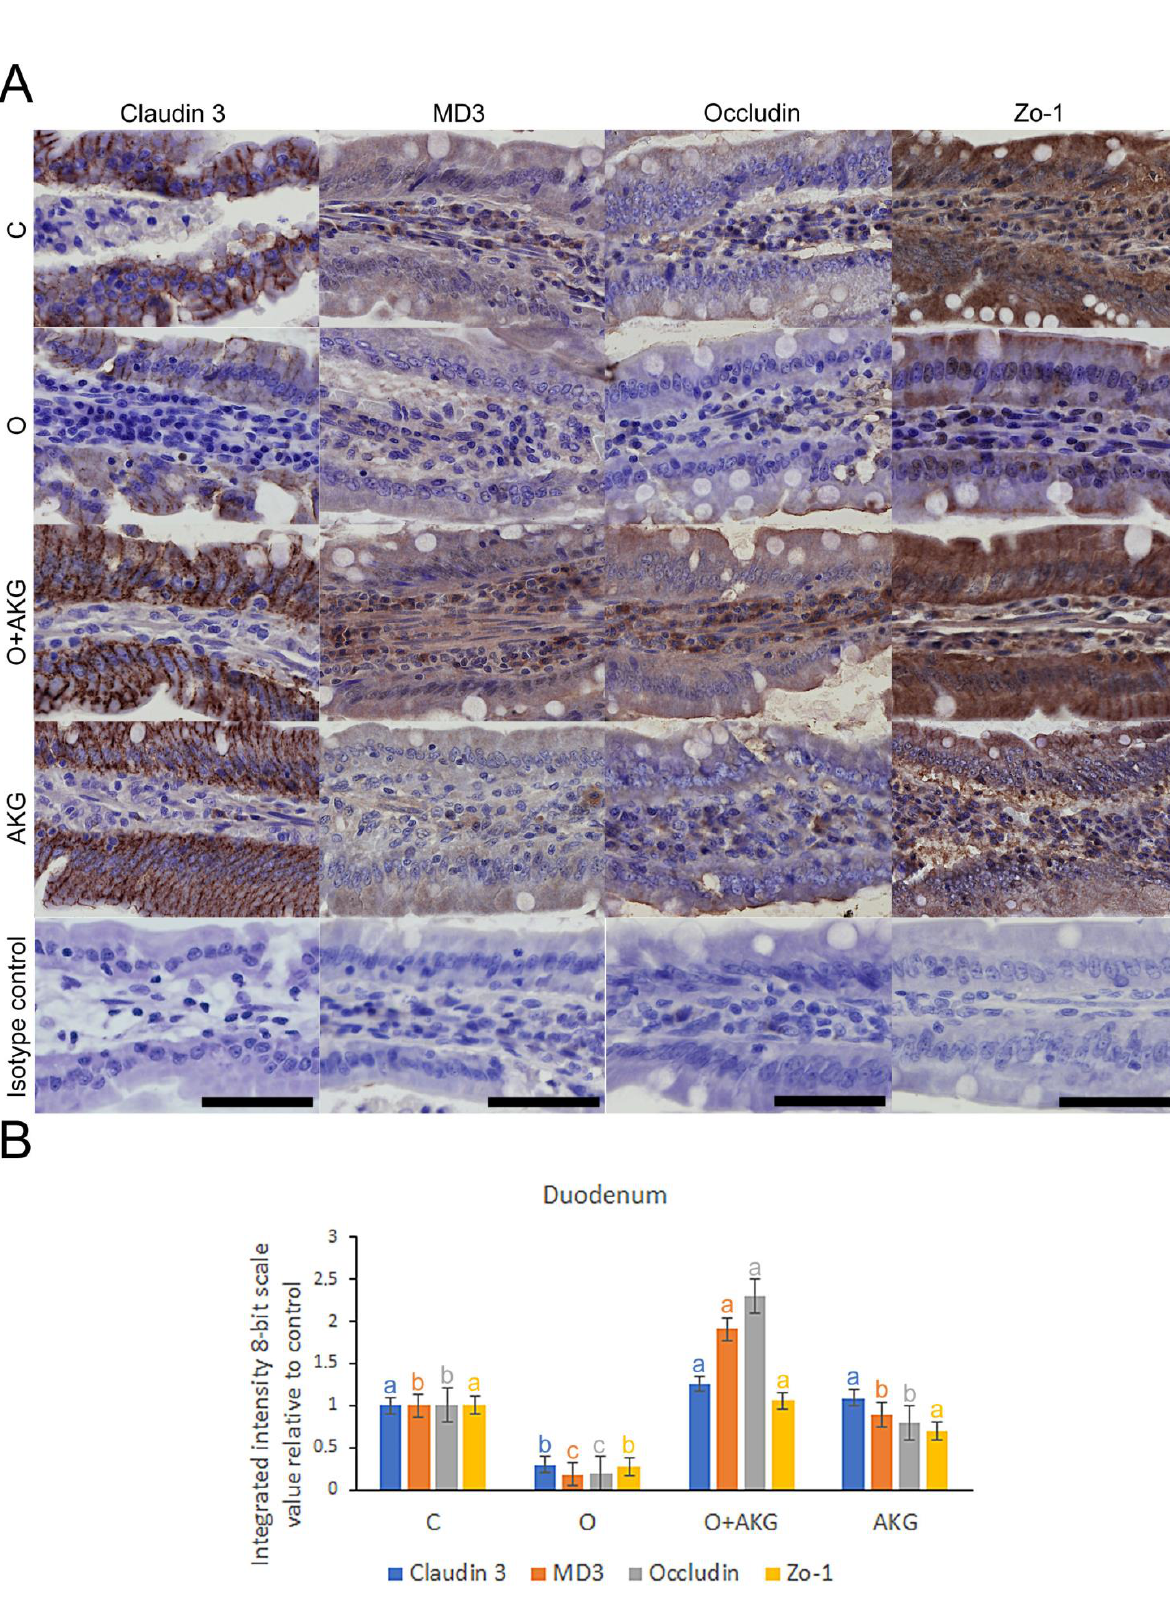
Figure 3. Effects of bariatric surgery and alpha-ketoglutarate (AKG) administration on selected tight junction proteins of the intestinal barrier. ( A ) Representative images of the immunolocalization and distribution of claudin 3, MD3, occludin and Zo-1 in the rat duodenum. C—control group undergoing sham surgery; O—group undergoing gastric bypass surgery; O + AKG—group undergoing